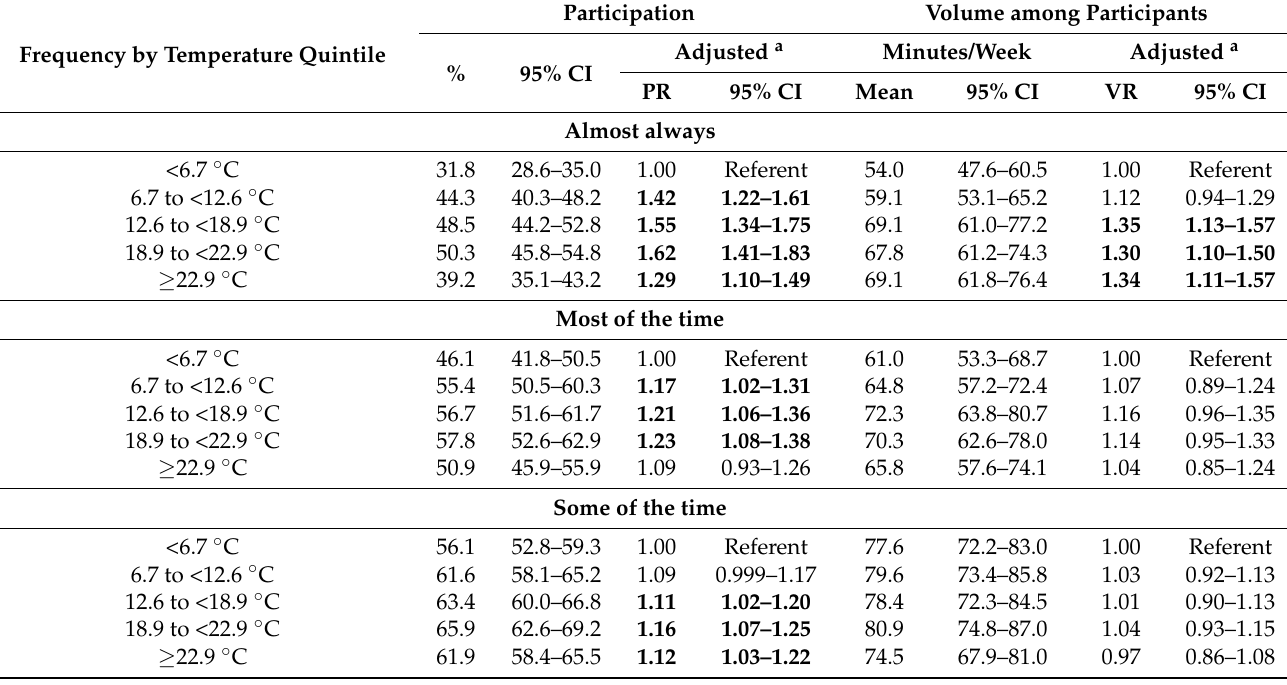
Table 4. Prevalence and volume of leisure walking (among participants) by frequency of reporting weather as a barrier by temperature